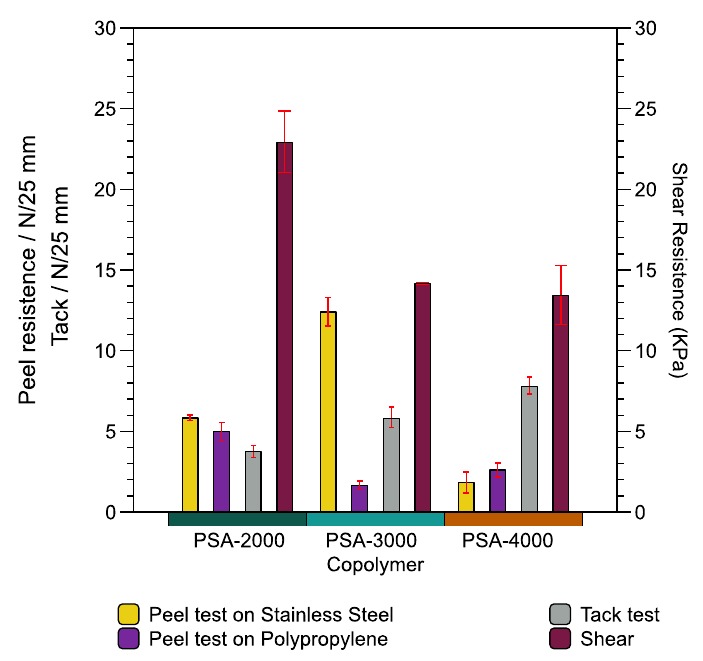
Figure 9. Adhesive properties of PSA-2000, PSA-3000, and PSA-4000 copolymers.